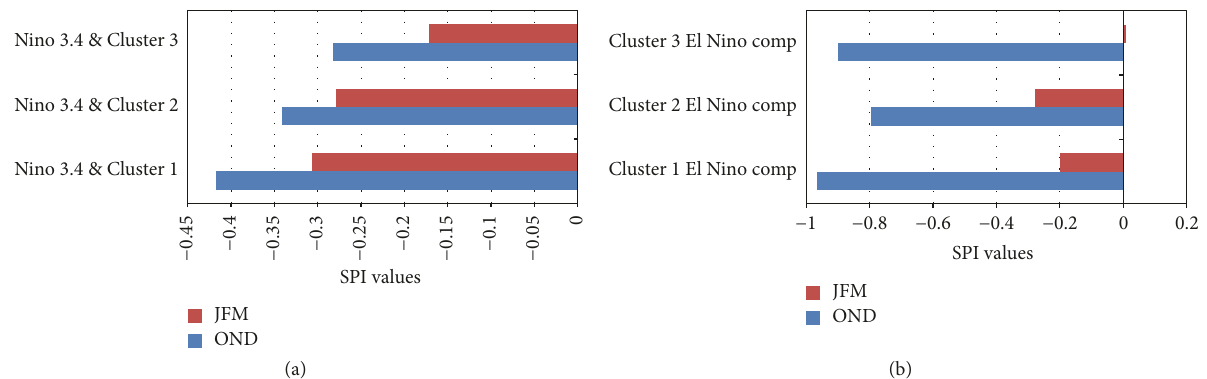
Figure 9: (a) Relationship between ENSO and the three clusters and (b) the El Nino composite SPI values for the three clusters during OND and JFM. The data is from 1960 to 2013 and the El Nino composites are comprised of the lowest Nino 3.4 values of 1965/66, 1972/73, 1982/83, 1987/1988, 1991/92, 1997/98, and